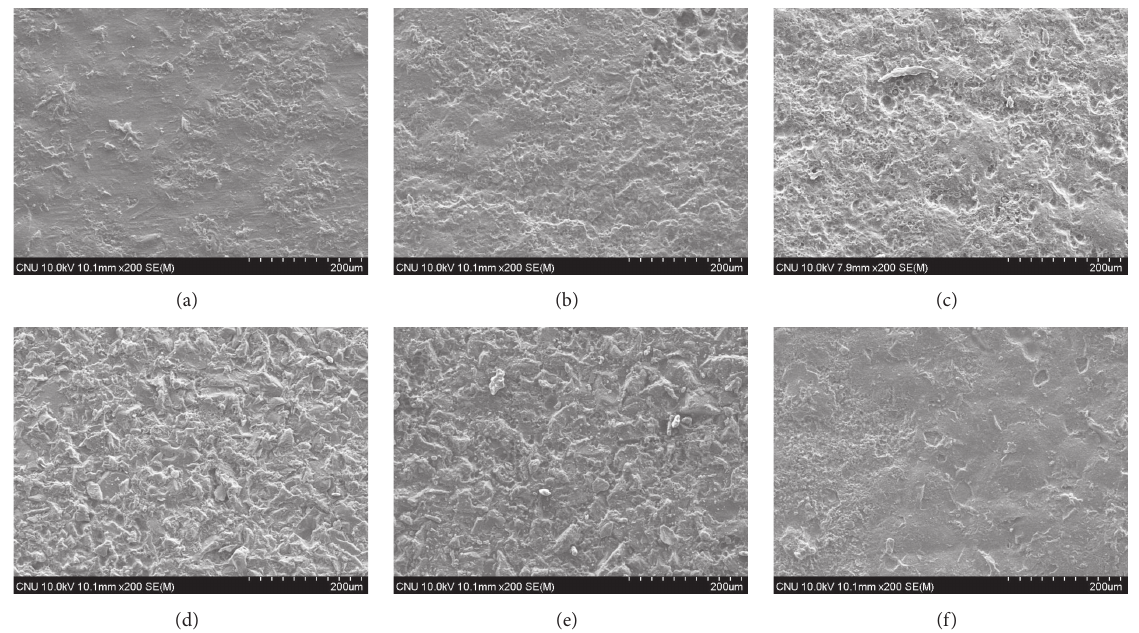
Figure 3: SEM photographs of polyketone/NR composite surface; (a) nonaged, (b) thermal aged at 105 ∘ C (8 days), (c) 125 ∘ C (8 days), (d) 180 ∘ C (2 days), and (e) 180 ∘ C (8 days), and (f) humidity aged at 99% (500h).